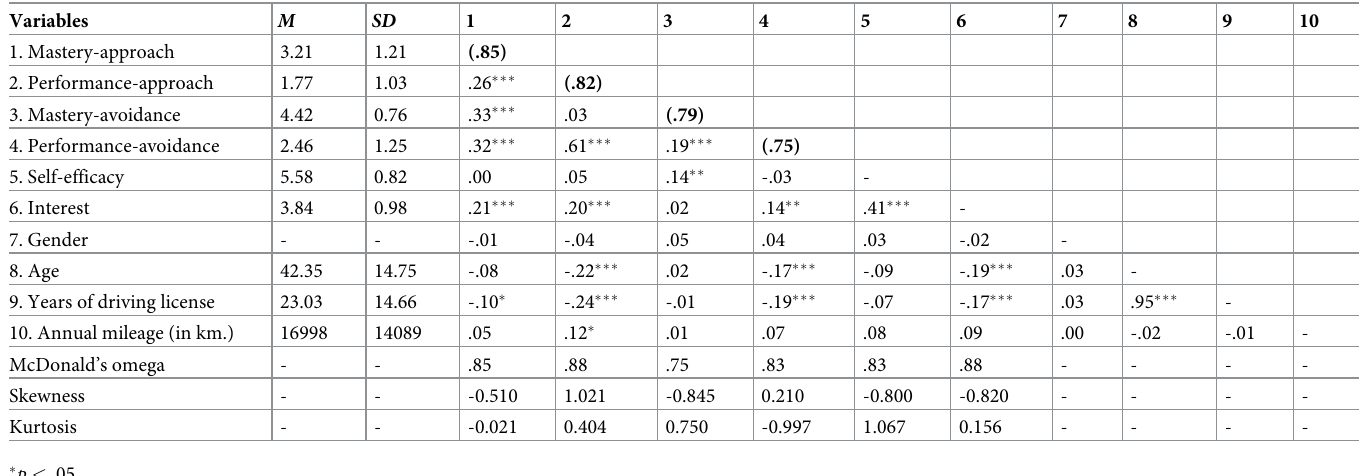
Table 2. Descriptive statistics of the final sample (without outliers), correlations between scales, internal consistency, Skewness, Kurtosis, and discriminant validity.